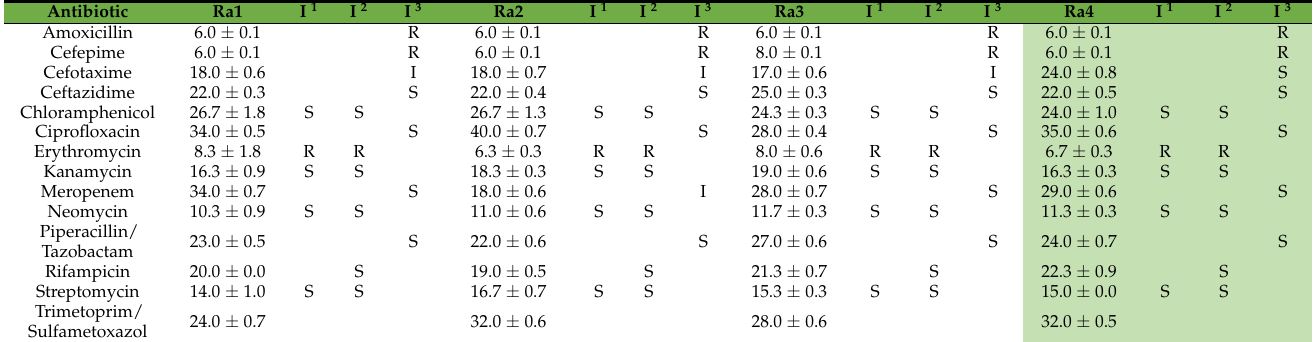
Table 3. Intrinsic antibiotic resistance of the different R. aquatilis strains, isolated from fava bean and pea nodules, determined using the disc diffusion method on solid MH medium. Values indicate the halo diameter (mm) (mean and standard errors, n = 3 dishes).